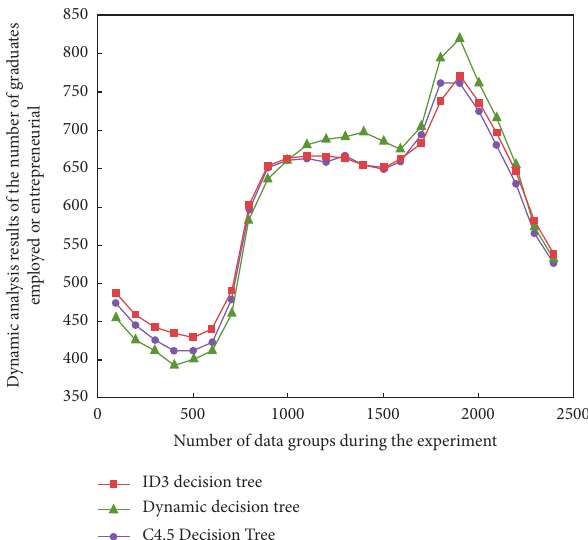
Figure 6: Preliminary analysis results of the experiment.